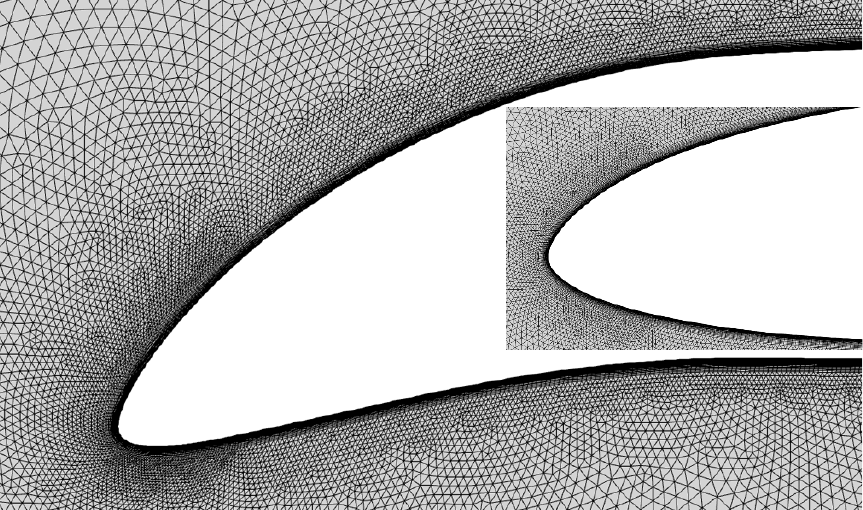
Figure 4. A dynamic mesh model of the variable morphing leading edge airfoil.